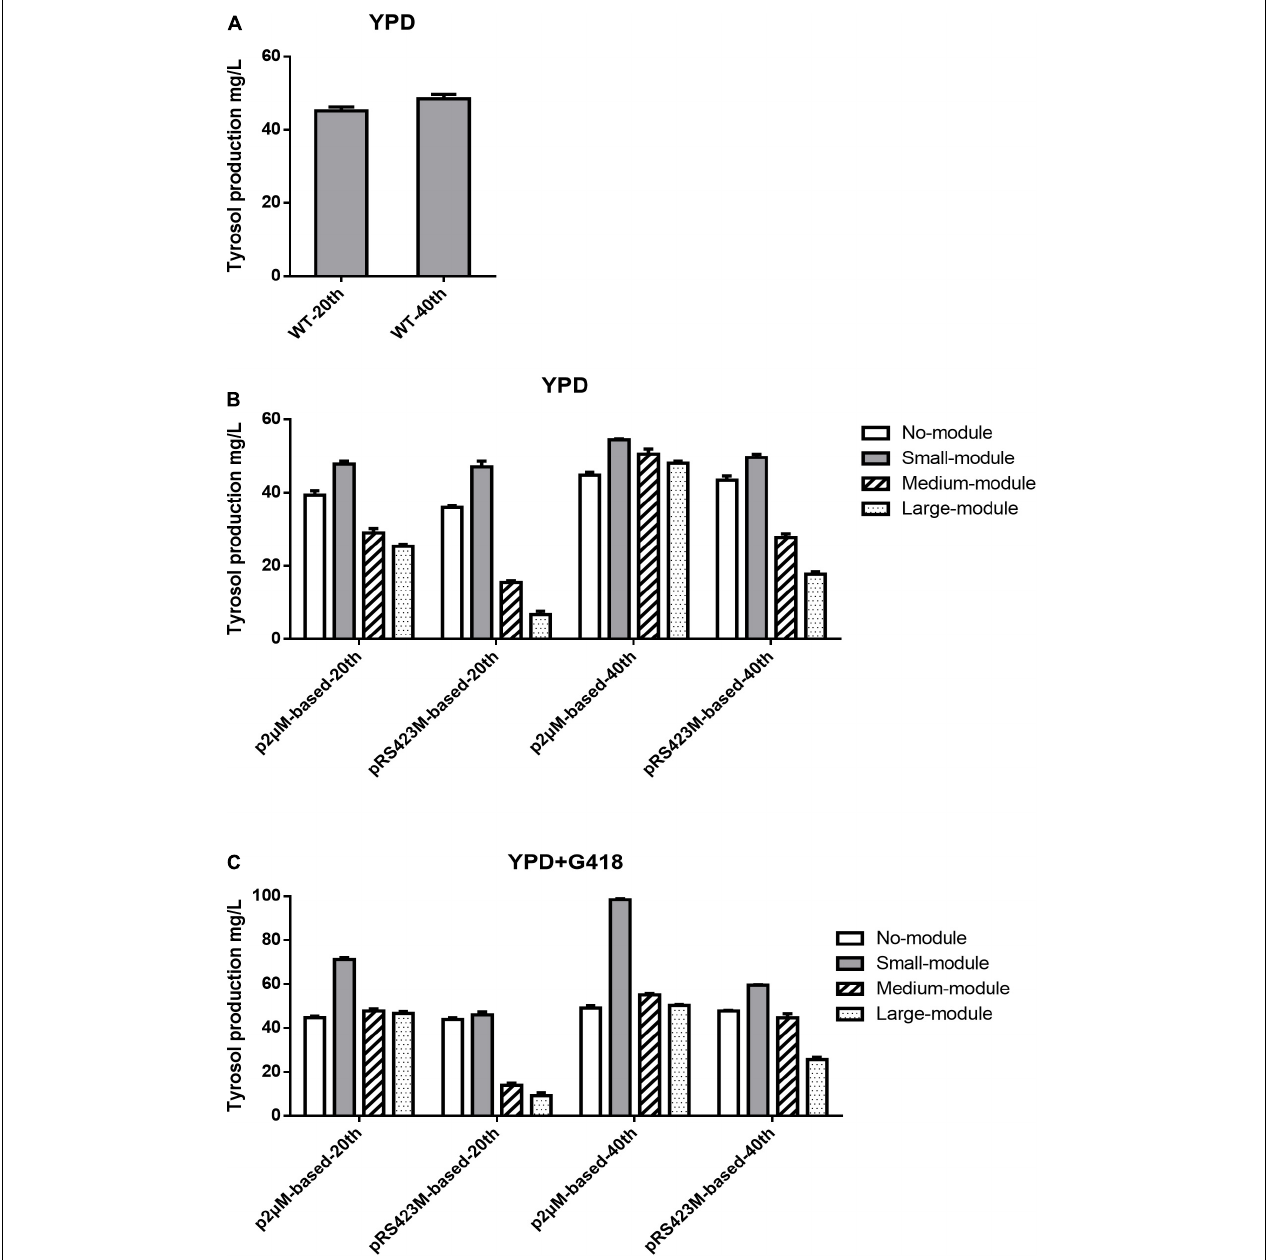
FIGURE 2 | Tyrosol production of strains containing a single plasmid with modules of different sizes after fermentation for 20 and 40 generations. (A) Tyrosol production of the WT strain CEN.PK2-1C. (B) Tyrosol production of strains CEN.PK2-1C with p2 µ M-based plasmids and CEN.PK2-1C with pRS423M-based plasmids after fermentation in YPD medium. (C) Tyrosol production of strains CEN.PK2-1C with p2 µ M-based plasmids and CEN.PK2-1C with pRS423M-based plasmids after fermentation in YPD medium with 200 µ g/ml